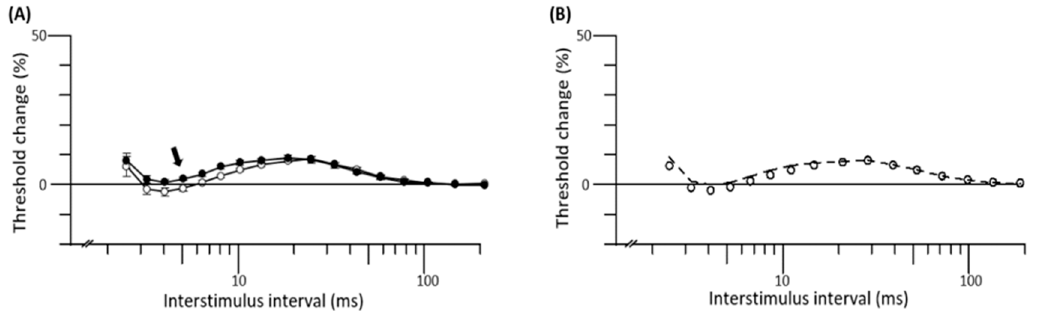
Figure 4. Tibial nerve recovery cycle graphs of mean group data and mathematical modeling. ( A ) Graph of the mean group recovery cycle data (open circles represent chow group and closed circles represent CAF group). Superexcitability was measured at 5 ms indicated by the arrow. ( B ) Mathematical modeling of nerve excitability reduced the discrepancy between groups with decreased sodium–potassium pump